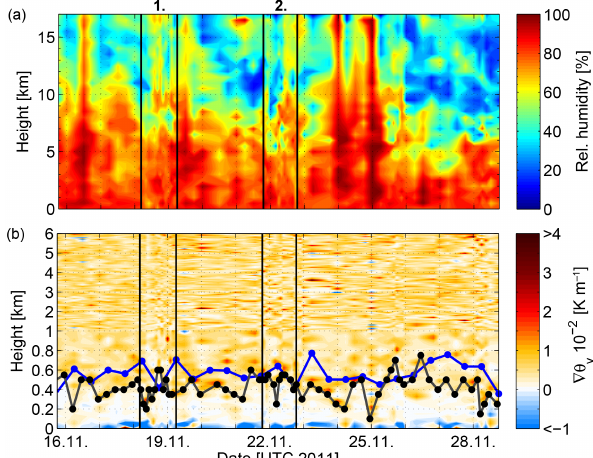
Figure 3. (a) Relative humidity from radiosondes up to 17km height, the mean cold point tropopause level. The dashed lines and the two numbers above the figure indicate the two 24h stations. (b) Virtual potential temperature gradient as indicator for atmo- spheric stability (red for stable, white for neutral and blue for unsta- ble) with MABL height derived from radiosondes (black curve) and from ERA-Interim (blue curve). The y axis is non-linear. The lower 1km is enlarged to display the stability around the MABL height. The vertical lines and the two numbers above the figures indicate the two 24h